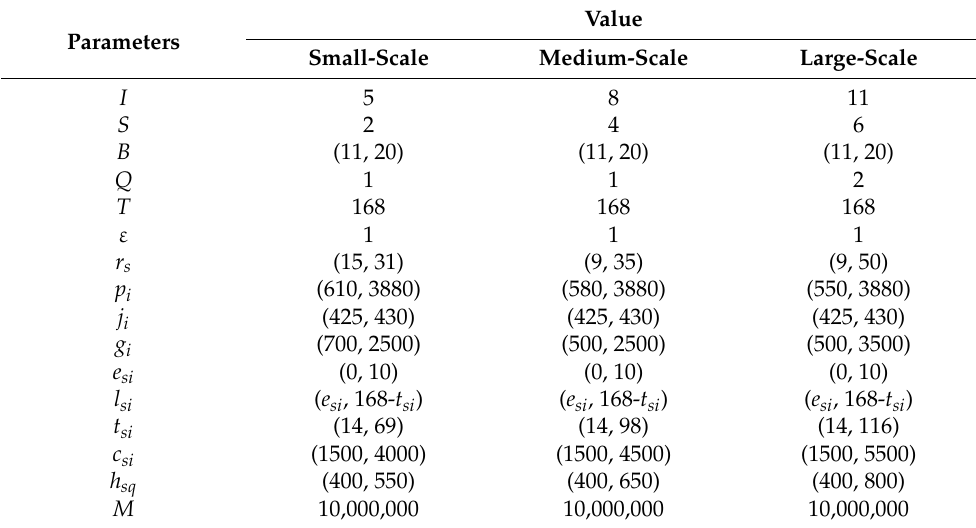
Table A1. Parameter settings. An appropriate value setting of parameters is helpful to complete the numerical experiments. The data of parameters come from a certain forwarding company (one of the authors once worked in the company). The first column on the left is the symbol of parameters related to the model (see Section 3.2). There are divided into three scales (the small scale, the medium scale and the large scale) according to the value of parameters.